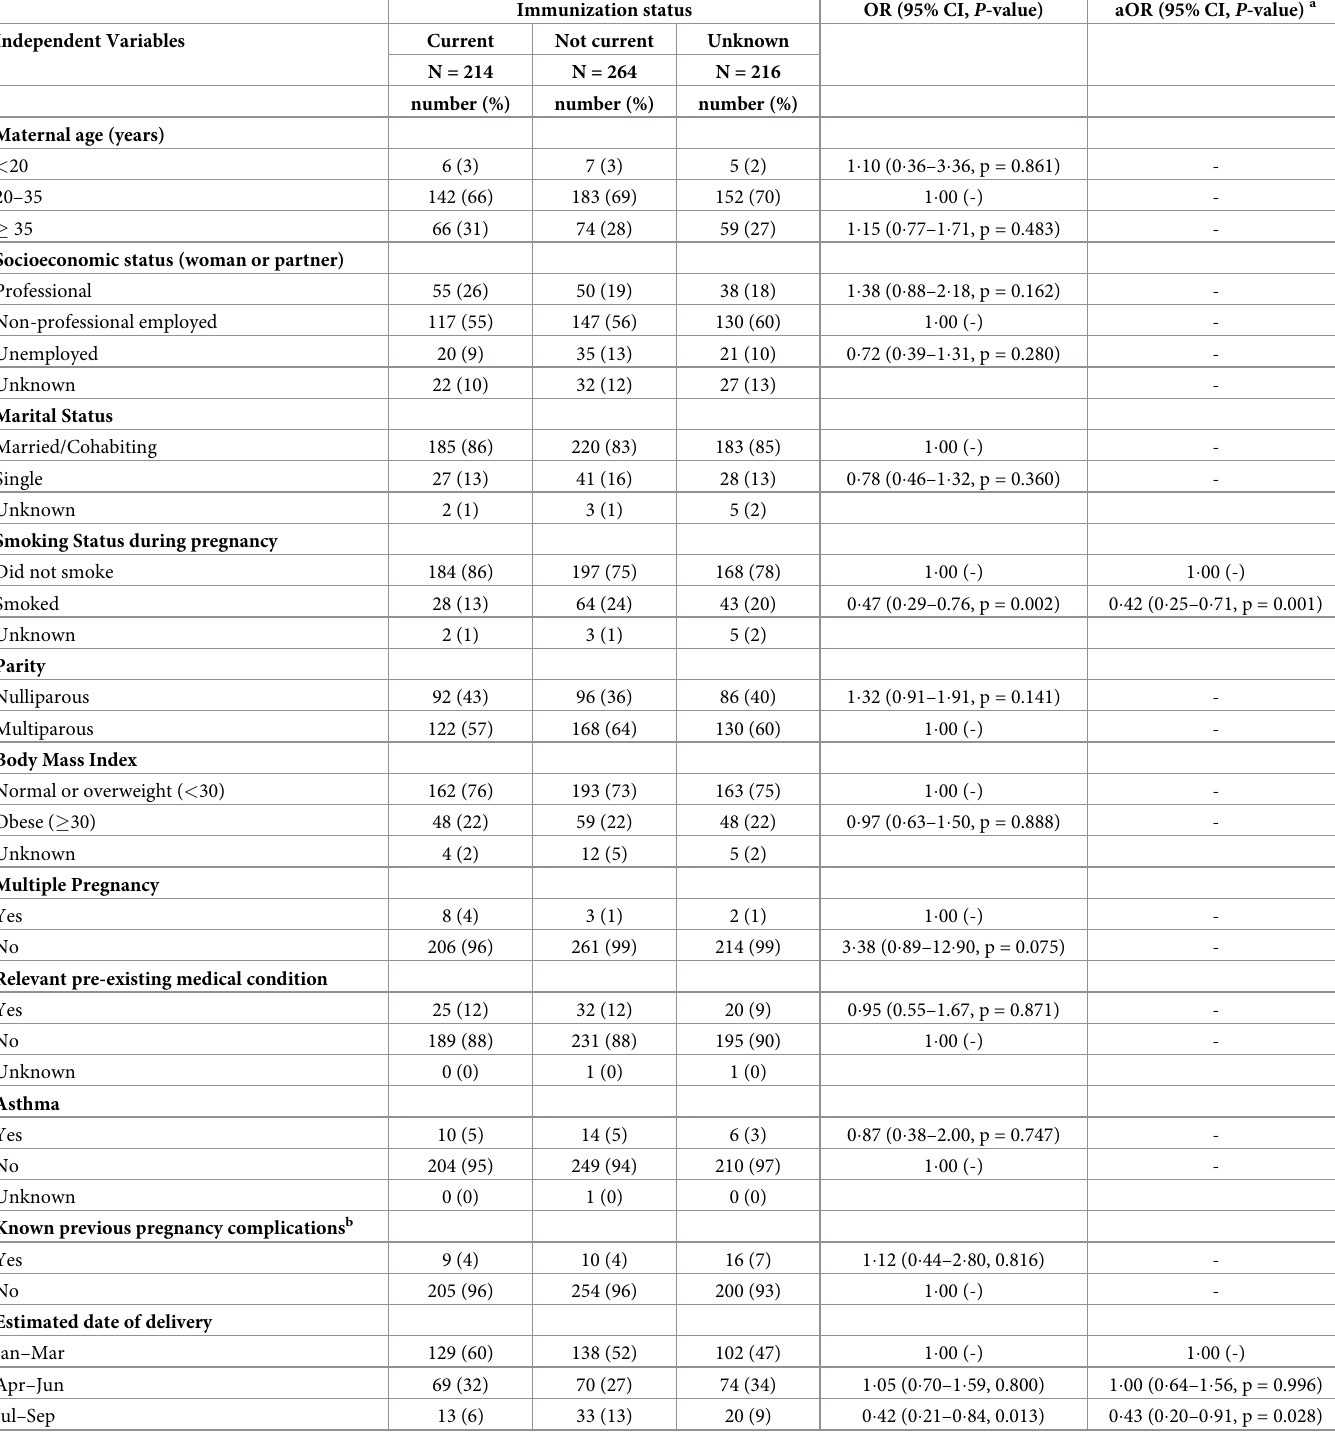
Table 4. Characteristics associated with immunization in comparison